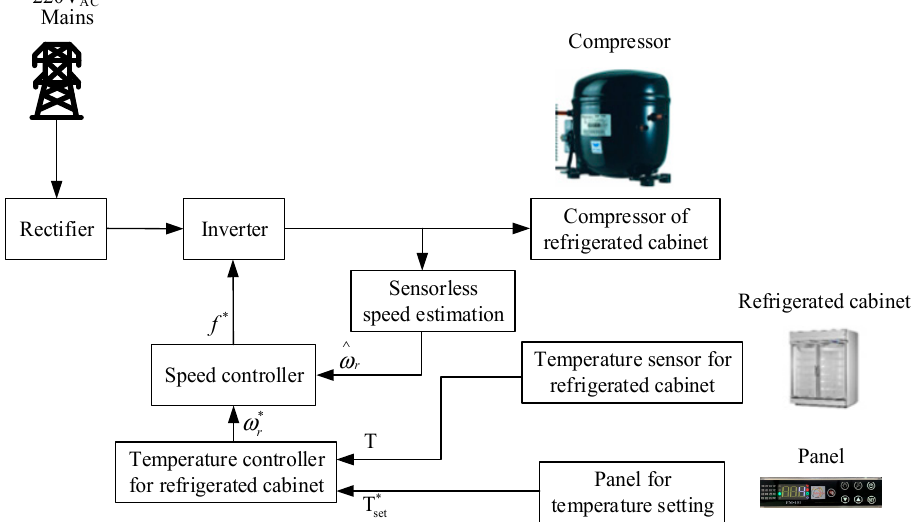
Figure 1. Architecture of temperature control system for refrigerated cabinets.